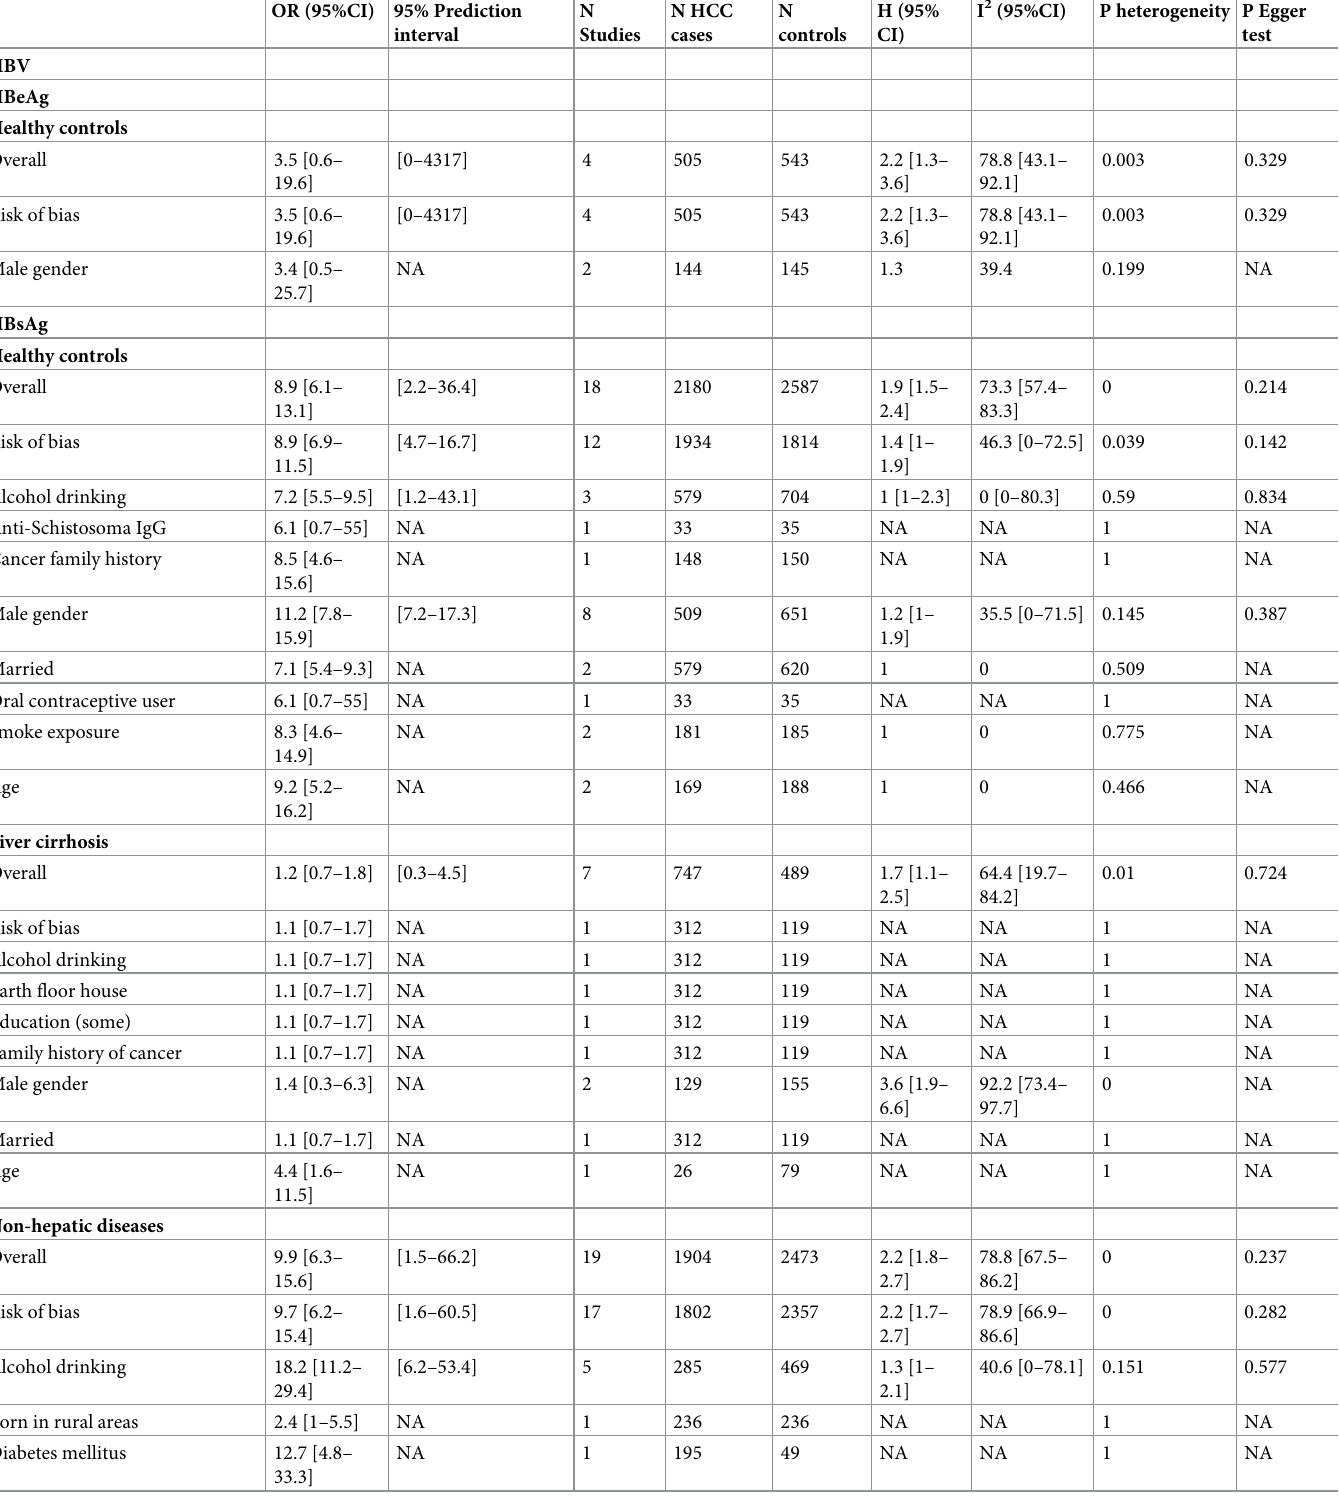
Table 1. Hepatocellular carcinoma development in people with and without viral hepatitis B, C, and D infections in Africa and influence of